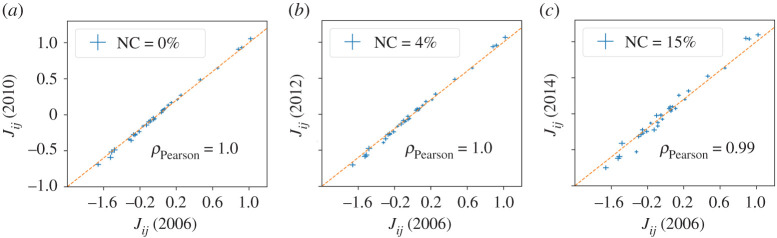
Comparisons between the J(2) parameters of different years (2006–2010 in (a), 2006–2012 in (b), 2006–2014 in (c)). The dotted line represents the relation of equality (i.e. the diagonal of the first half-plane in the Cartesian space. The percentage of non-compatible (NC) reported refers to the percentage of components that cannot be considered as equal with a t-test and a threshold p-value of 0.05.